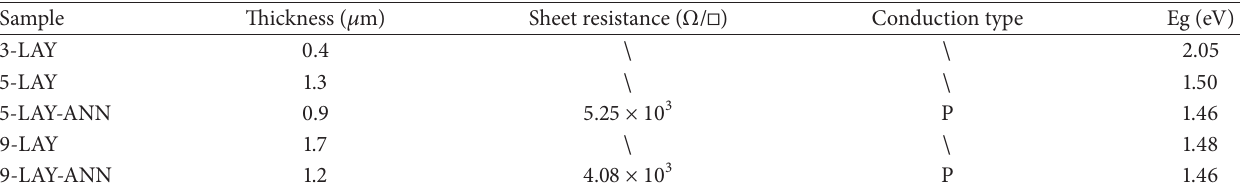
Figure 4: SEM photographs of CZTS films. (a) and (c) Surface and cross section of 9-LAY. (b) and (d) Surface and cross section of 9-LAY- ANN. Table 4: Characterizations of the CZTS films.